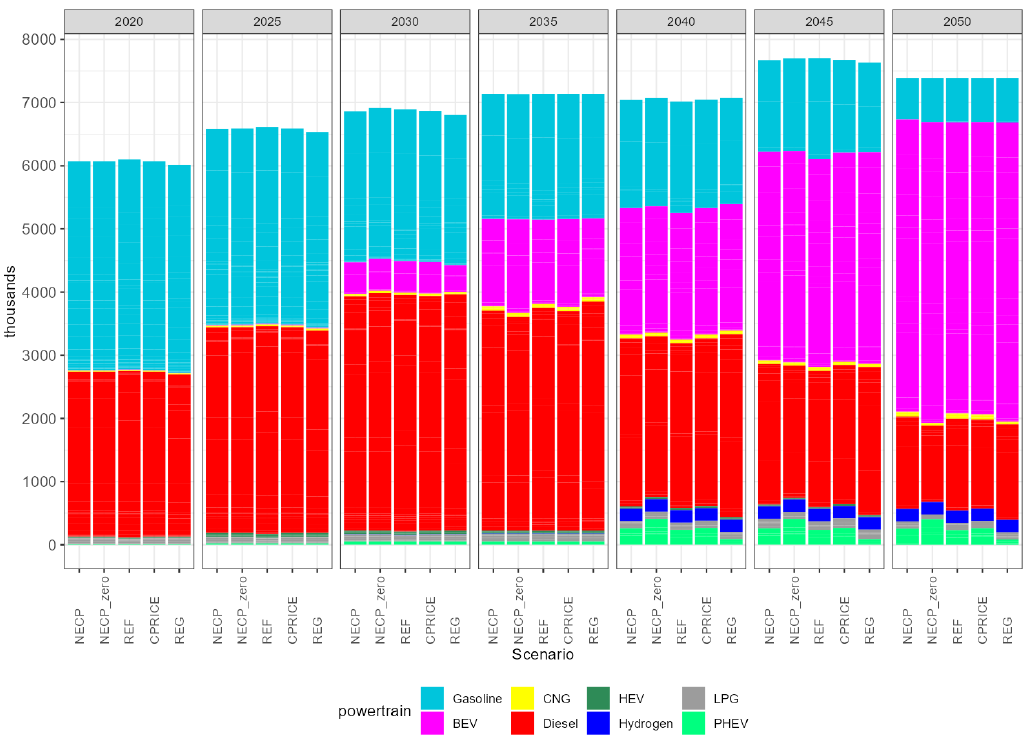
Figure 14. Structure of passenger car fleet by powertrain.